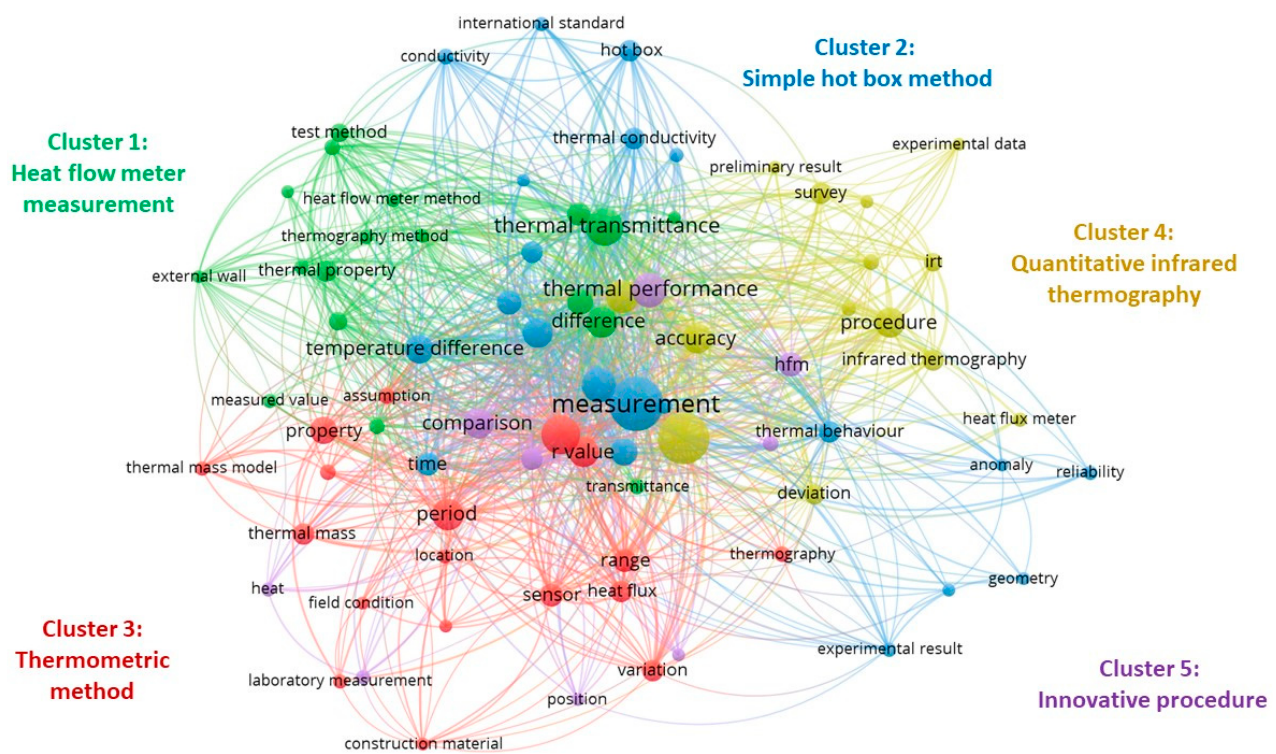
Figure 9. Co-occurrence network of keywords on the topic “ thermal transmittance measurement of building *” (source: authors’ elaboration using VOS viewer, based on Scopus data).